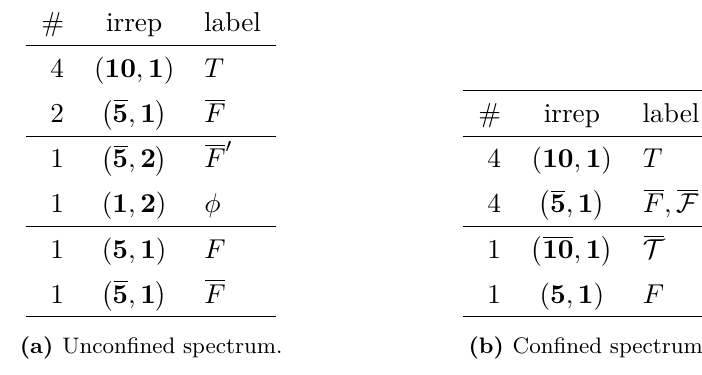
Table 1. Summary of the SU(5) × SU(2) s quantum numbers of the chiral superfield content of the 4 3 model. The vector-like pair at the bottom of table 1a can be decoupled, resulting in a separate 4 3